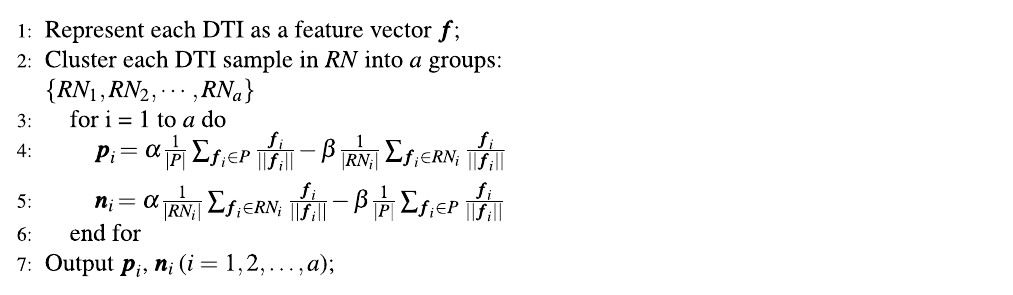
Algorithm 2. Computing the representative positive and negative DTI prototypes.